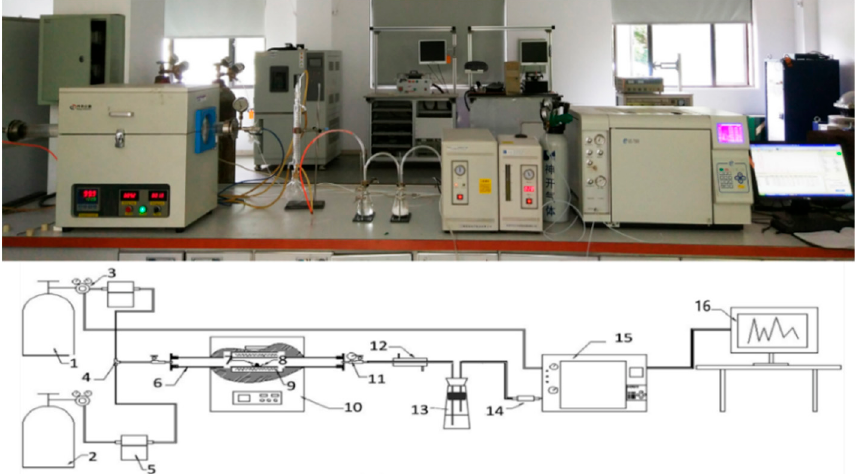
Figure 1. Experimental platform for laboratory ‐ scale pyrolysis. 1: N2; 2: Other gases (air); 3: Pressure